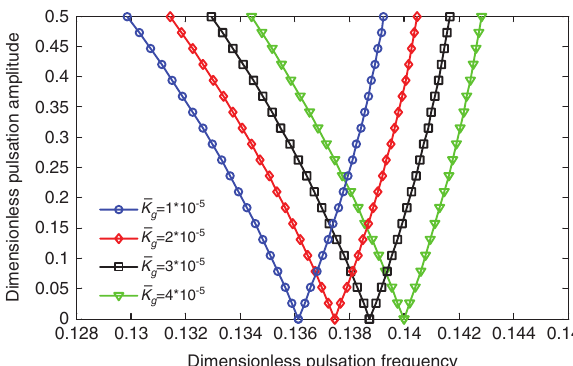
Figure 10: Effect of the shear constants of viscoelastic foundation on the dimensionless pulsation amplitude versus dimensionless pulsation frequency.